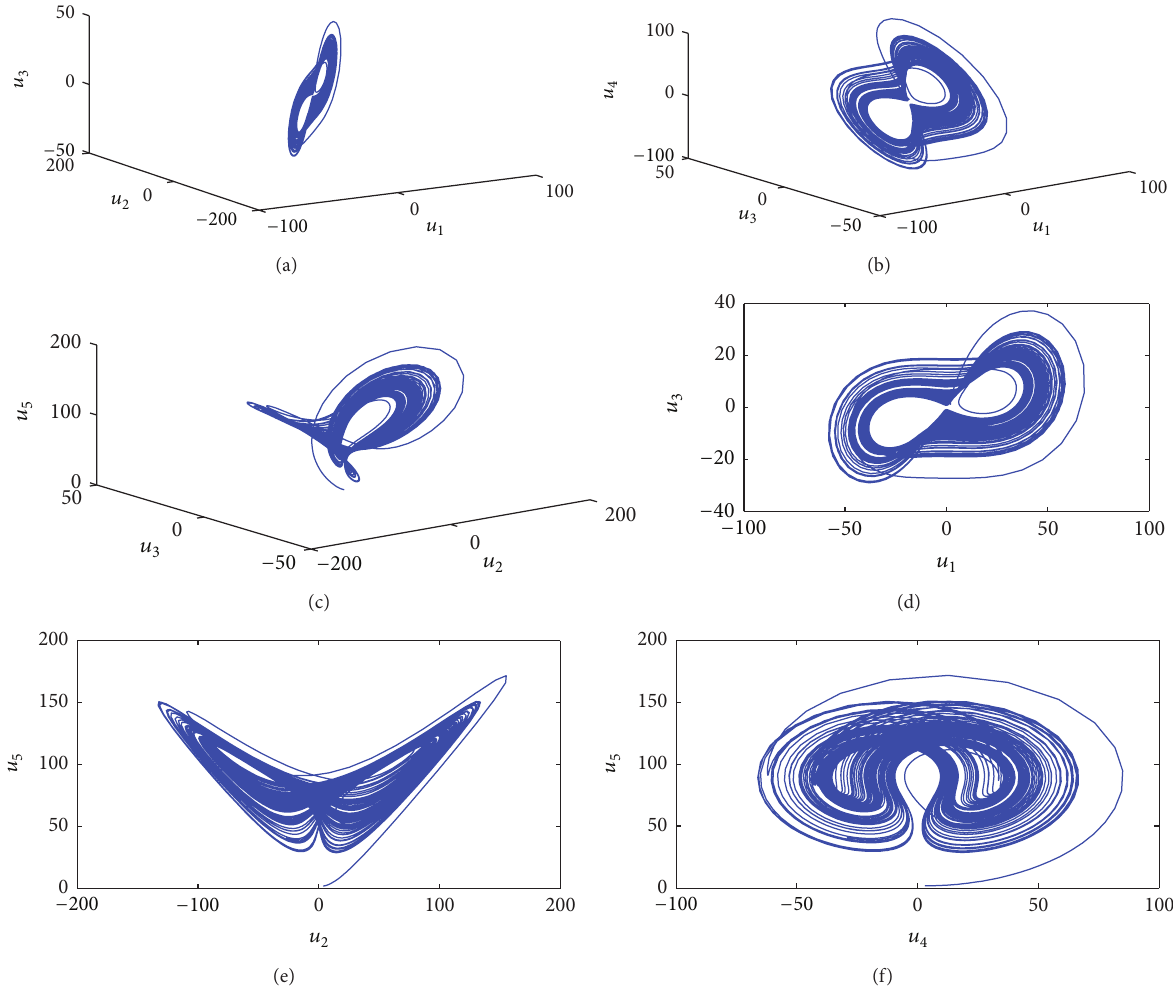
Figure 1: Chaotic attractor for system (6). (a)–(c) Projections in 3D space; (d)–(f) projections in 2D